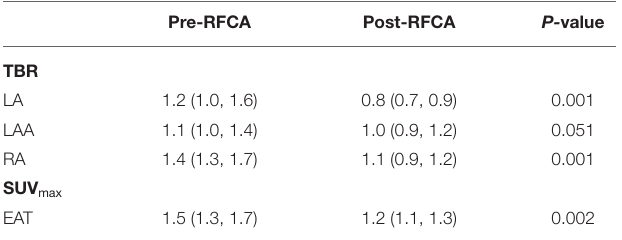
TABLE 3 | Comparisons of FDG activities pre- and post-RFCA in the atrium and EAT. Pre-RFCA Post-RFCA P- value